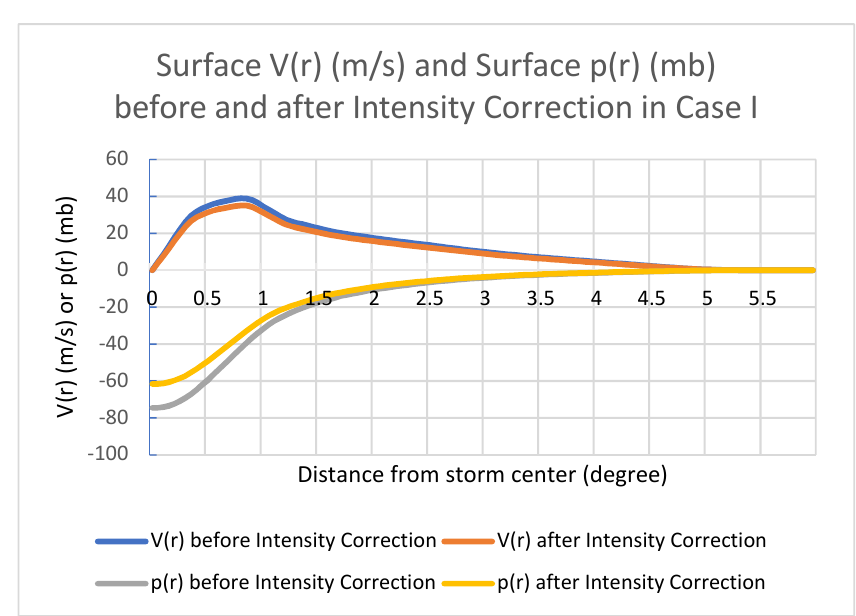
Figure 3. Same as Figure 1 but for storm intensity correction in Case I (wind speed reduced by ~10%).